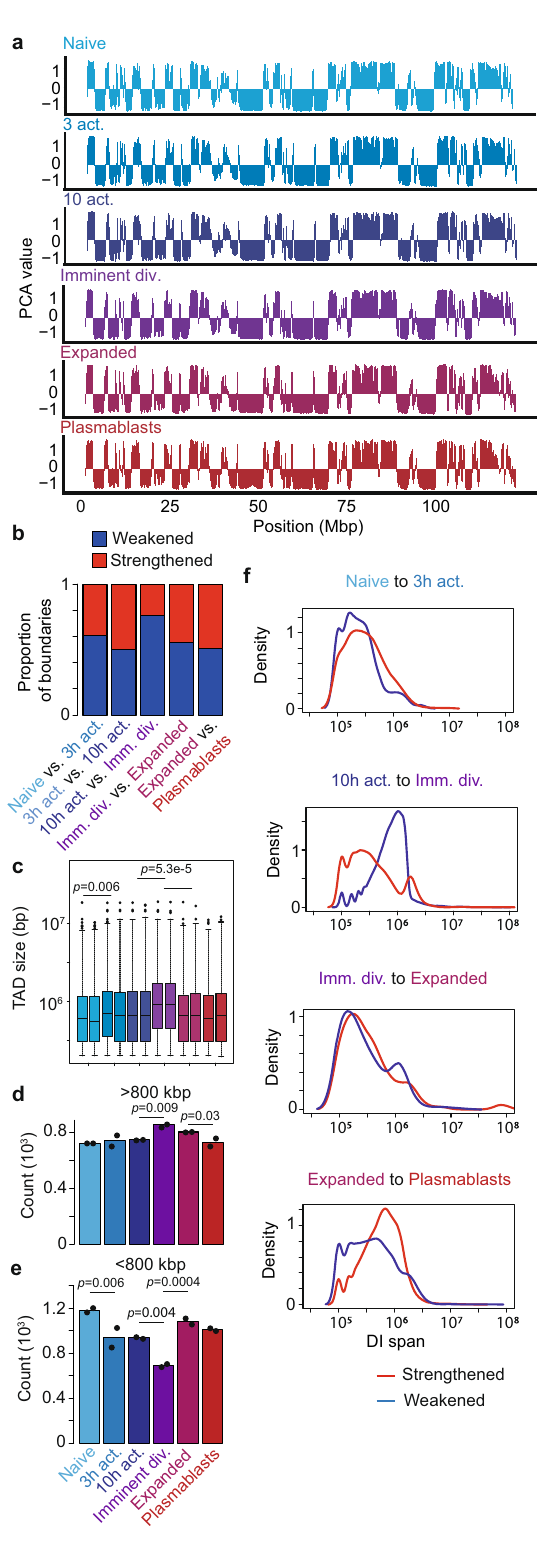
( p = 2.46 × 10 − 6 ) (Supplementary Data 4). The lack of early changes in genome organization may be explained by the transcriptional focus of the cell at these times. For example, in the fi rst 3 h post-activation, gene ontological analysis of transcriptional changes (Supplementary Fig. 1J, K) revealed that genes involved in ribosome biogenesis are signi fi cantly enriched